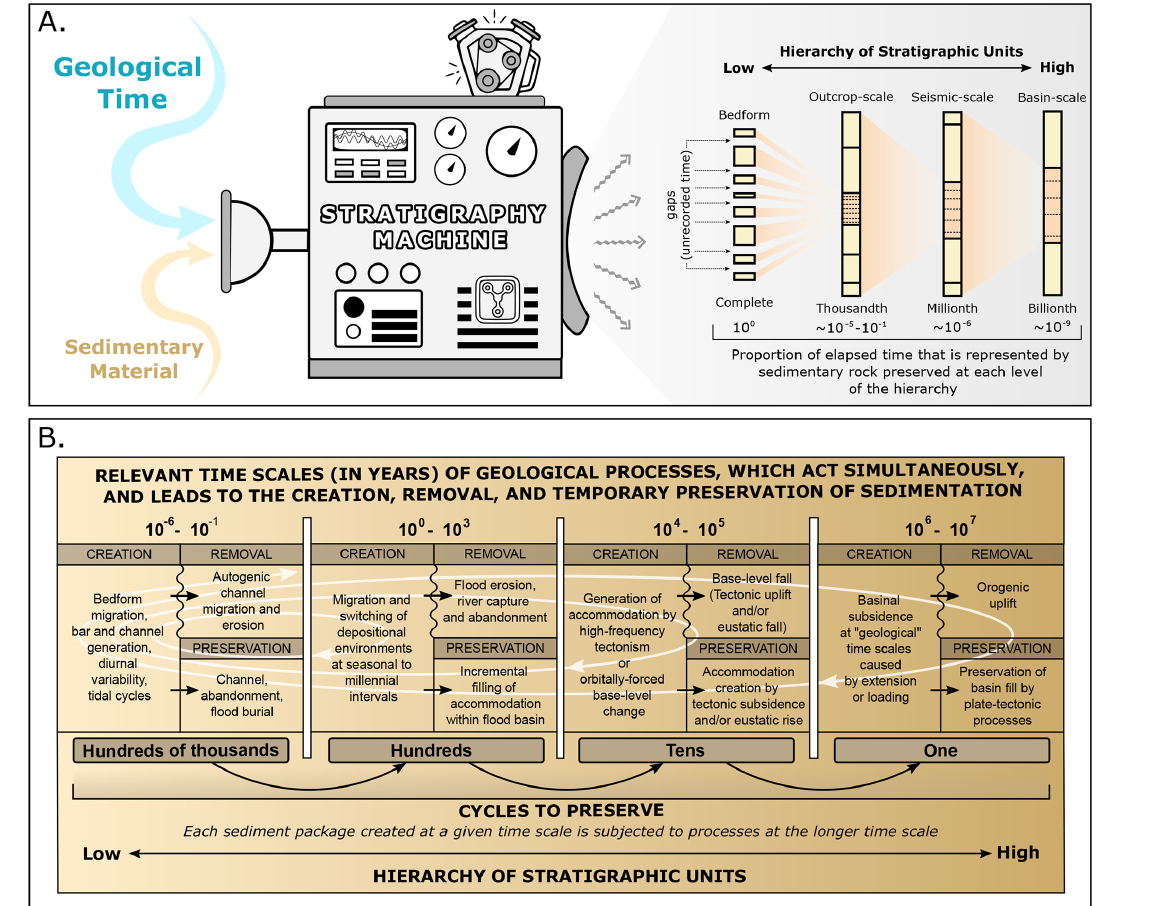
Figure 18. Stratigraphy machine. (a) Playful representation of the “stratigraphy machine” concept that generates the stratigraphic record, organizing geological time into hierarchically preserved sedimentary units and hiatus surfaces from the bedform to the entire basin fill (based on Holbrook and Miall, 2020). (b) Table illustrating the stratigraphy machine’s operation, which considers the simultaneous action of several accumulation, removal, and preservation processes, which interact at different timescales to generate the rock record. For convenience, the timescale is subdivided into four broad intervals. The diagram should be read from left to right, where at each time interval the sediments are first generated by the depositional processes, and what is not removed on the surface is preserved in the subsurface, creating the initial succession. Over time, long-term processes affect this succession, with preservation and/or removal. In this way, long-term processes will affect short-term processes, as indicated by the loops at the bottom of the figure. It is estimated that a period equal to or greater than 10 7 years would be enough for all processes to perform a complete cycle. Due to the recurrent removal processes, numerous sedimentary gaps occur in the final product at all scales, and the rock record represents only a fraction of the elapsed time (modified from Holbrook and Miall,